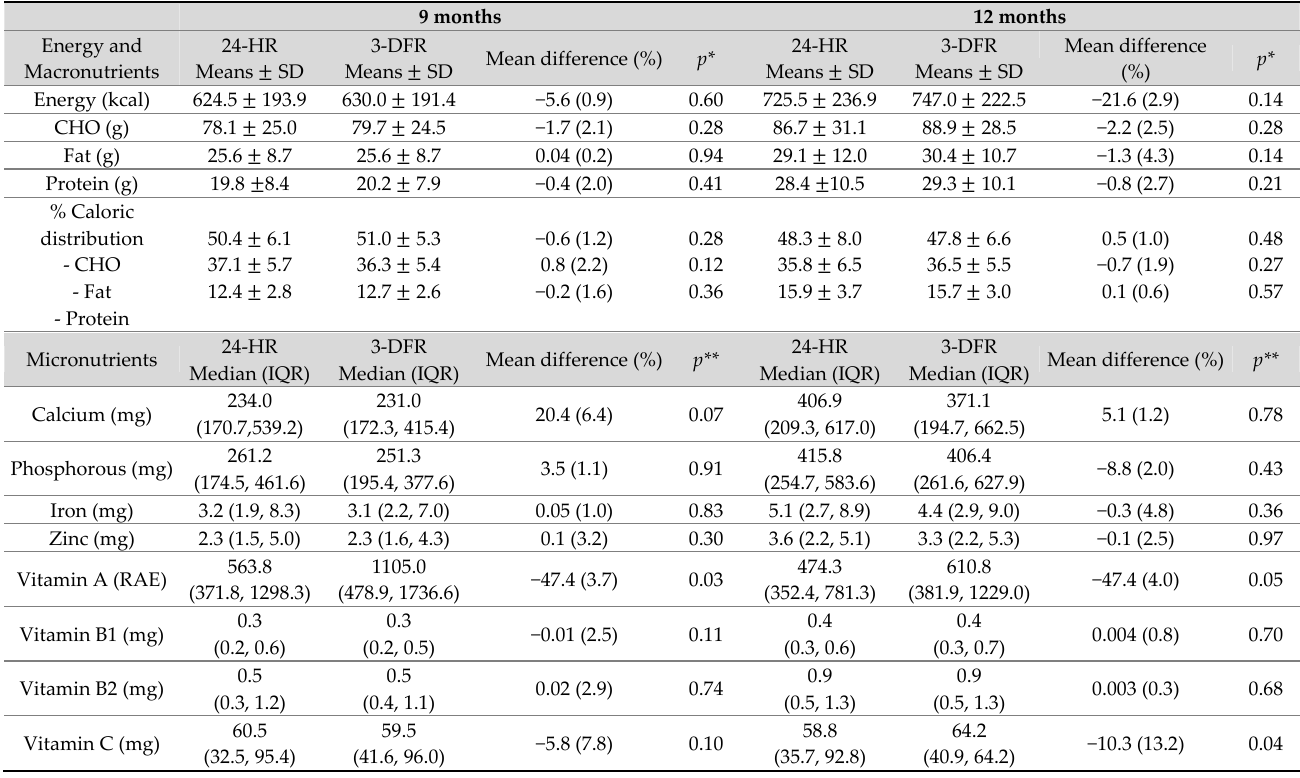
Table 2. Paired t -test/Wilcoxon signed rank test and mean difference of daily nutrient intakes compared between 24-h dietary recalls (24-HR) and 3-day food records (3-DFR).